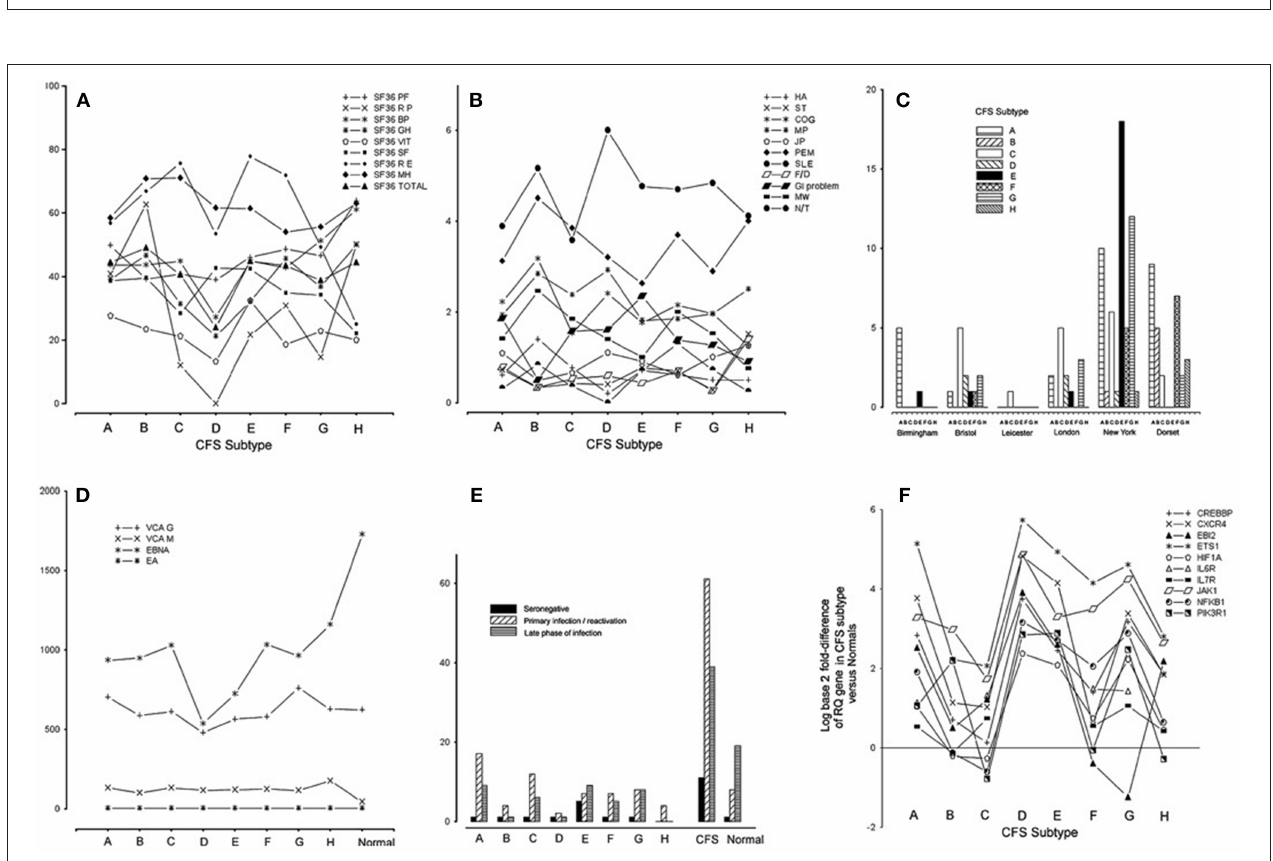
FIGURE 2 | (A) Medical Outcomes Survey Short Form-36 (SF36) domain and total scores for each chronic fatigue syndrome/myalgic encephalomyelitis (CFS/ME) subtype: physical function (PF), physical role (RP), bodily pain (BP), general health (GH), vitality (VIT), social functioning (SF), emotional role (RE), mental health (MH), and total score (Total). (B) Scores indicating occurrence and severity of 11 clinical symptoms for each CFS/ME subtype: headache (HA), sore throat (ST), swollen glands (GLA), cognitive defect (COG), muscle pain (MP), joint pain (JP), muscle weakness (MW), post-exertional malaise (PEM), sleep problems (SLE), fainting/dizziness (F/D), gastrointestinal complaints (GI), numbness/tingling (N/T), spatial span (SSP), verbal recognition memory (VRM). (C) Histogram showing the numbers of CFS/ME patients of each subtype occurring in each of the six geographical locations. (D) Epstein-Barr virus (EBV) antibody titers [viral capsid antigen (VCA) IgM, VCA IgG, early antigen (EA) IgG, Epstein-Barr nuclear antigen (EBNA) IgG] in each CFS/ME subtype and the normal comparison group. (E) Distribution of categories of EBV serostatus (seronegative, primary/re-activation, late phase of infection) in the CFS/ME subtypes, A-H, in CFS/ME (all subtypes combined) and in normal controls. (F) Log (base 2) of fold-difference values of 10 human genes known to be important in EBV infection, in eight CFS subtypes (A-H). Reproduced from Figure 1 of reference no. 34 with permission from BMJ Publishing Group Ltd. (License number 4413611406714).